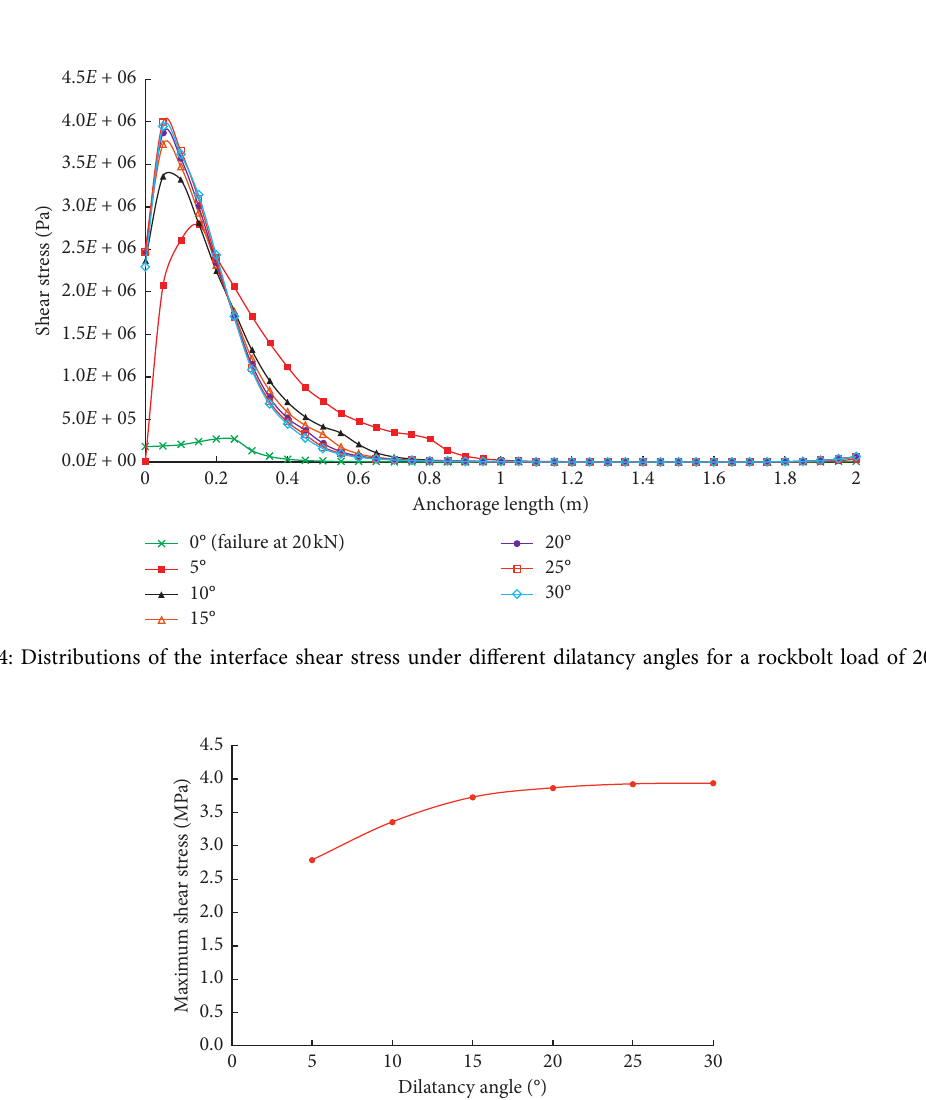
Figure 15: Maximum shear stress at the interface under different dilatancy